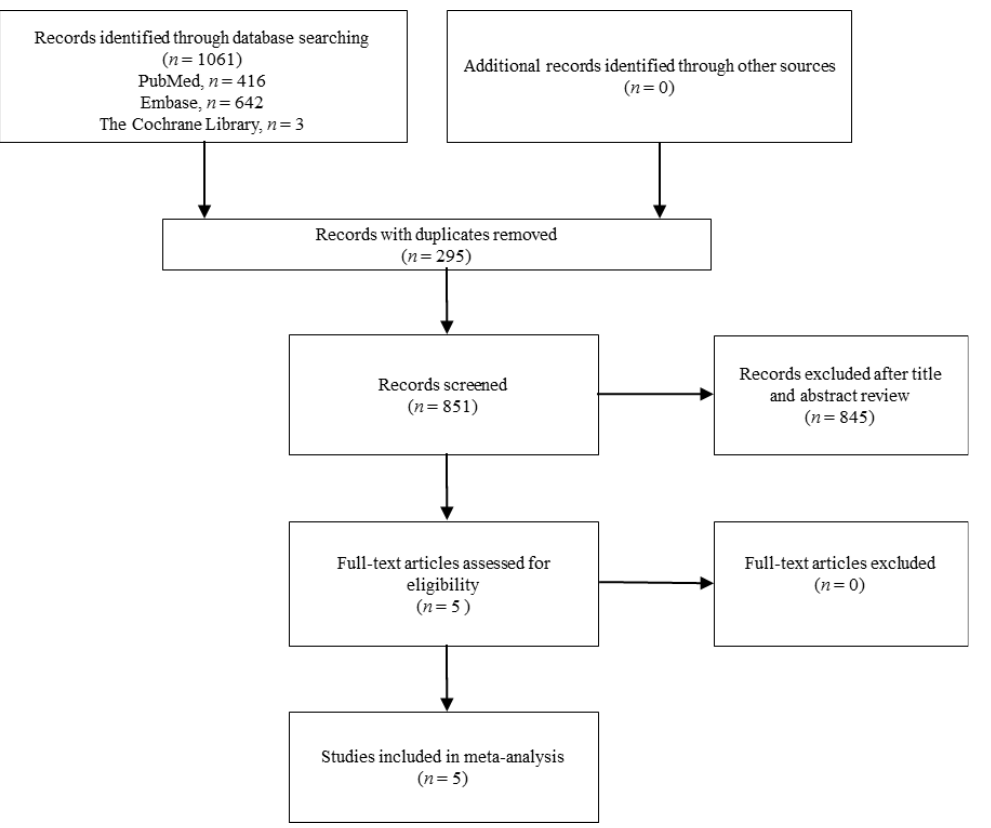
Figure 1. Flow diagram of the study selection process.